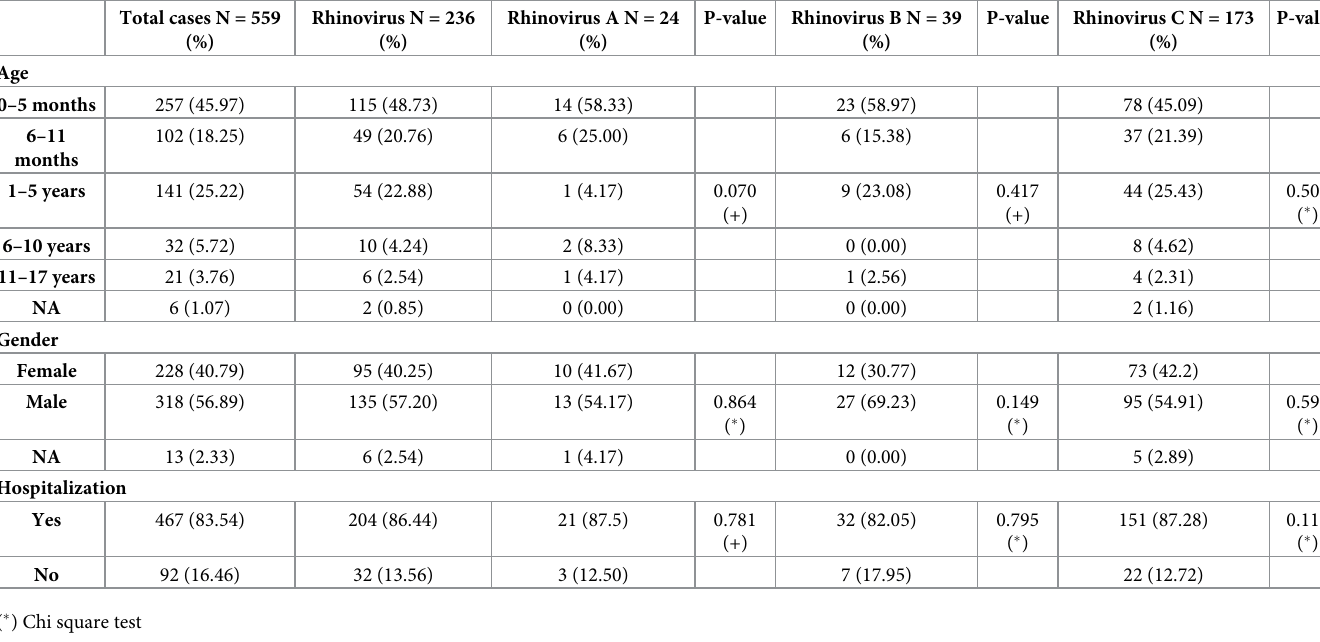
Table 1. Demographic characteristics of pediatric patients with clinical diagnosis of ARI and rhinovirus